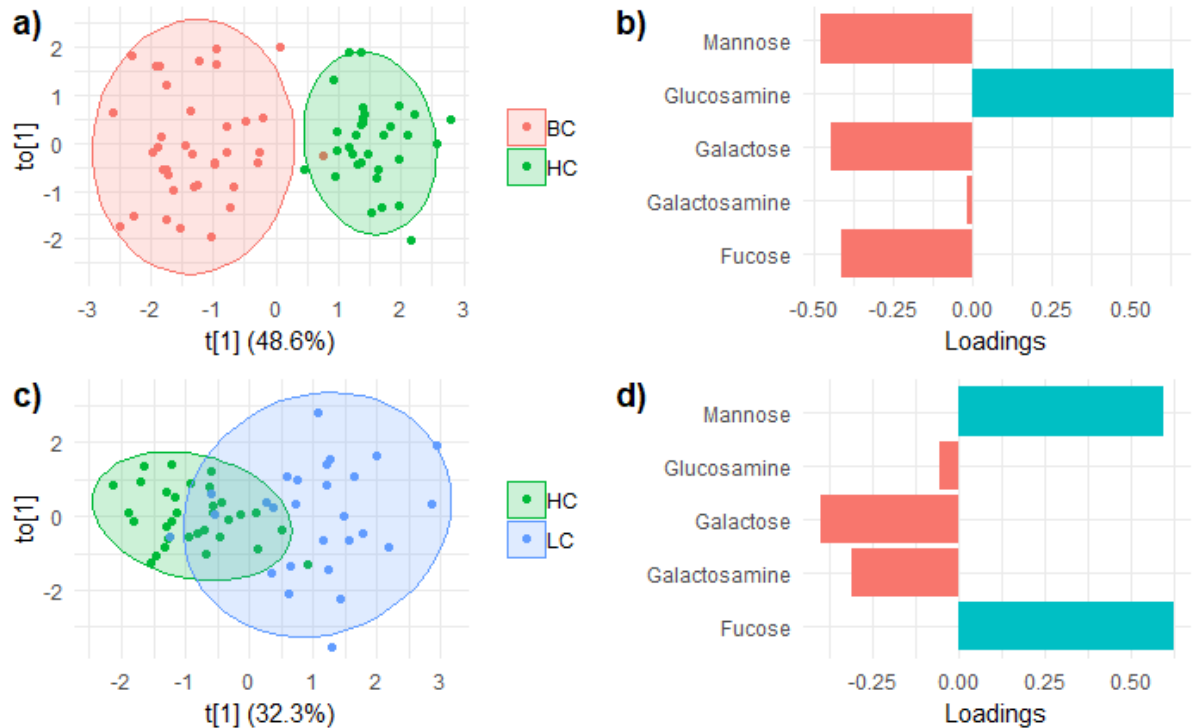
Figure 6. OPLS-DA score scatterplot of the hydrolyzed carbohydrates in ( a ) BC vs. HC and ( c ) LC vs. HC samples. The corresponding loading plots are reported in ( b , d ), respectively. corresponding loading plots are reported in ( b , d ),